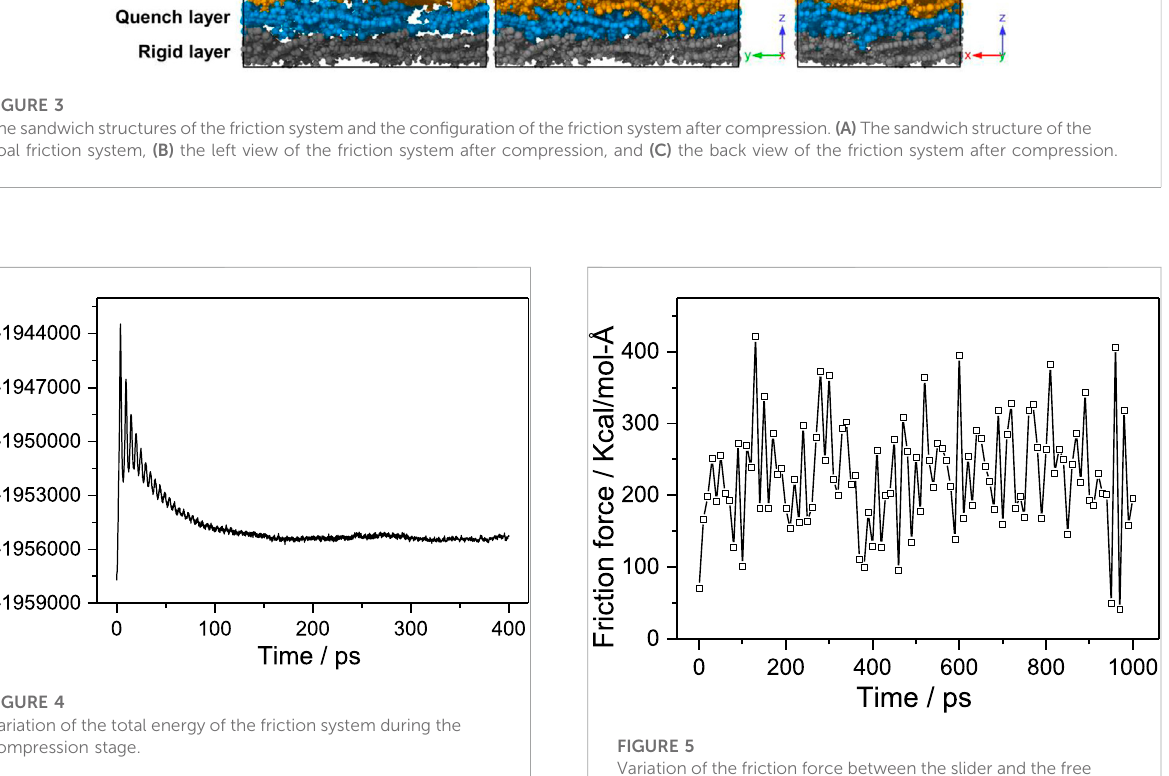
Variation of the friction force between the slider and the free layer with simulation